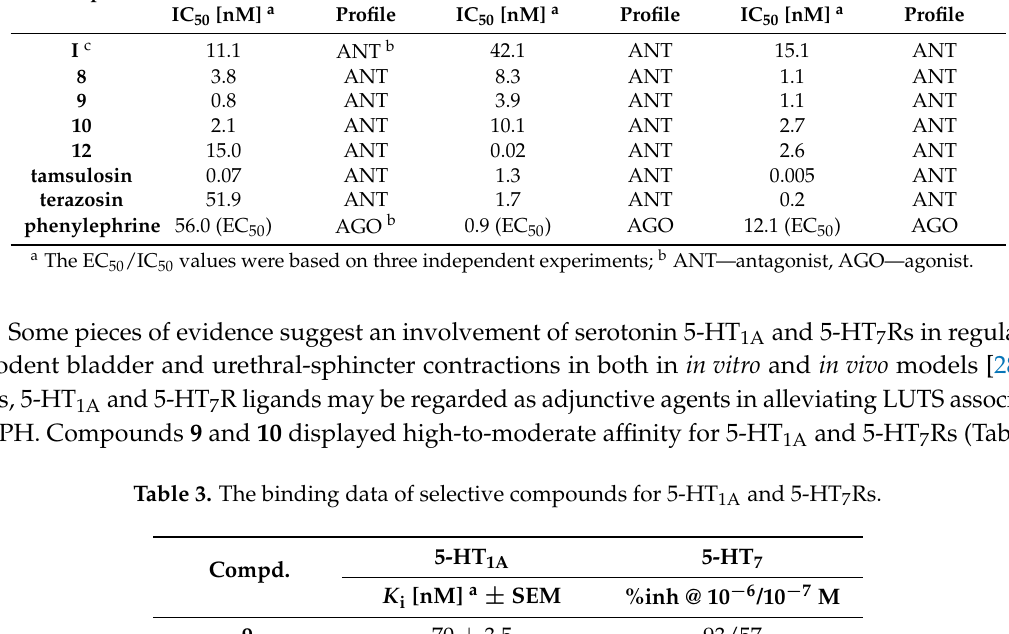
a K i values based on two independent binding experiments.